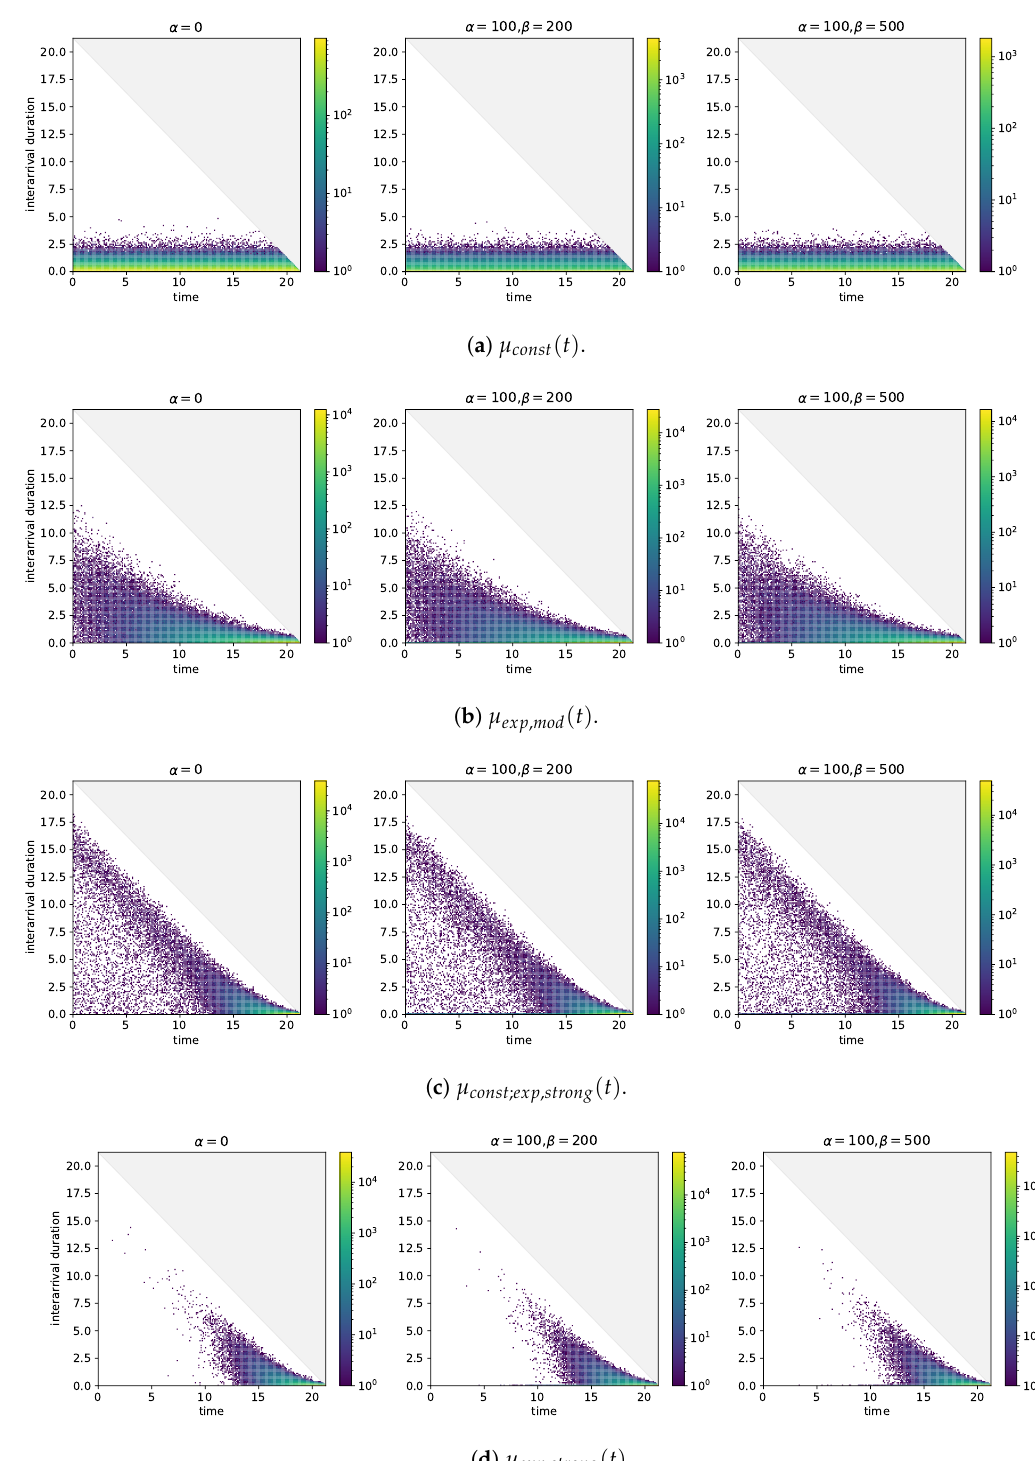
Figure A1. Two-dimensional histograms of event arrival times (horizontal axis) and durations between event arrival times and the arrival time of the next event (vertical axis) for different baseline intensities and self-excitation structures. T = 21.25, N = 10 4